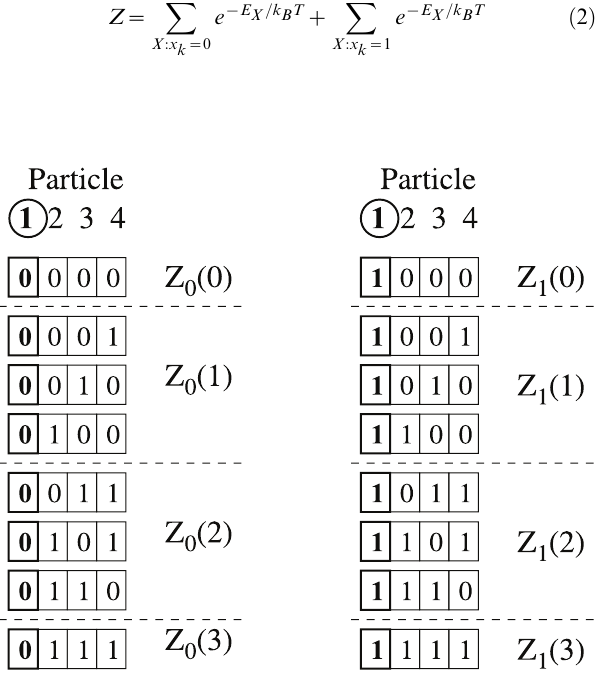
Figure 2. Partitioning of microstates. For a 4 particle system, the set of all possible 2 4 microstates are partitioned into subsets of states